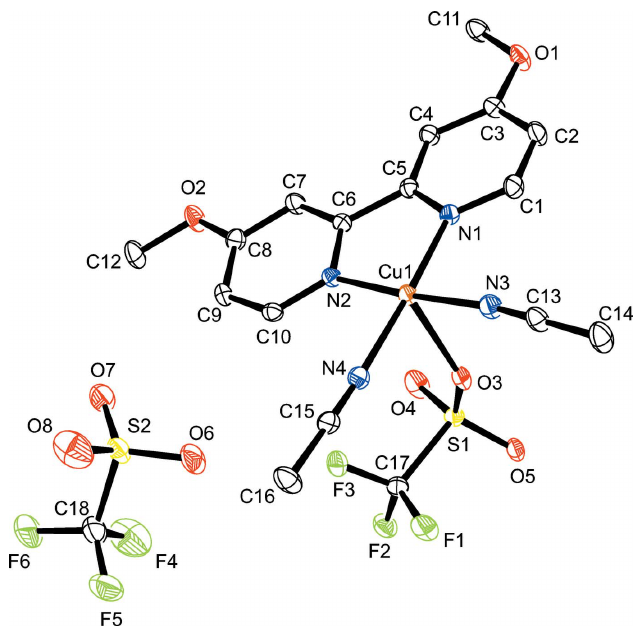
Figure 2 Perspective view of the packed structure of the title complex along the crystallographic b axis; H atoms are omitted for clarity.